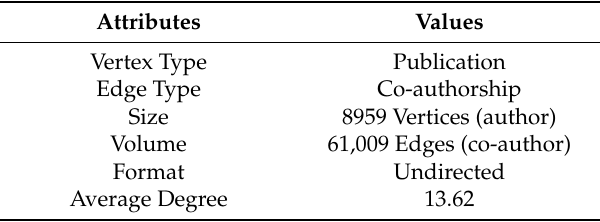
Table 1. Characteristics of the DBLP